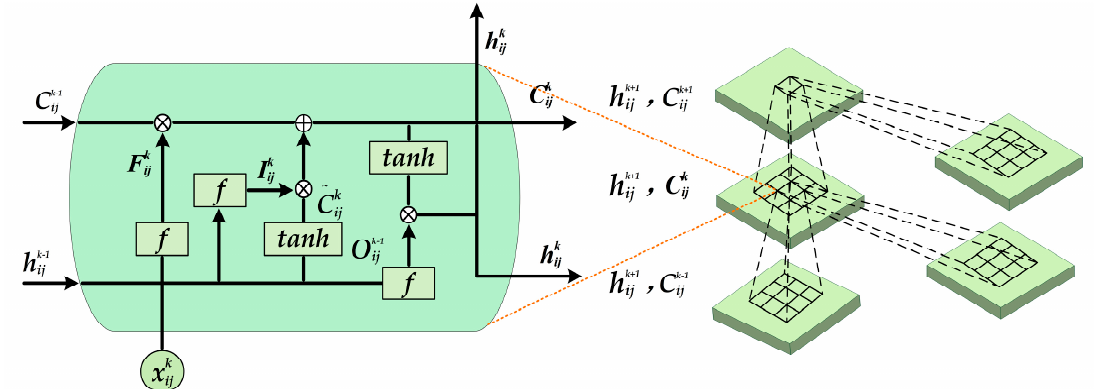
Figure 2. The structure of convolutional LSTM (CLSTM). Left, zoomed view of the inner computational unit called the memory cell. “ ⊕ ” and “ ⊗ ” represent the matrix addition and the dot product,